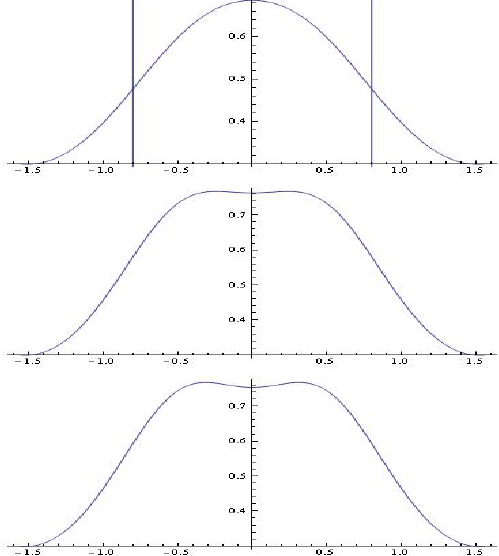
) for ( a ) a = 0.4; ( b ) a = 0.49; and , π 2 2